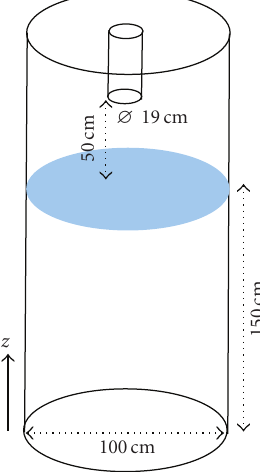
Figure 2: Geometry of a cylindrical tank filled with water through a nozzle above the free surface.